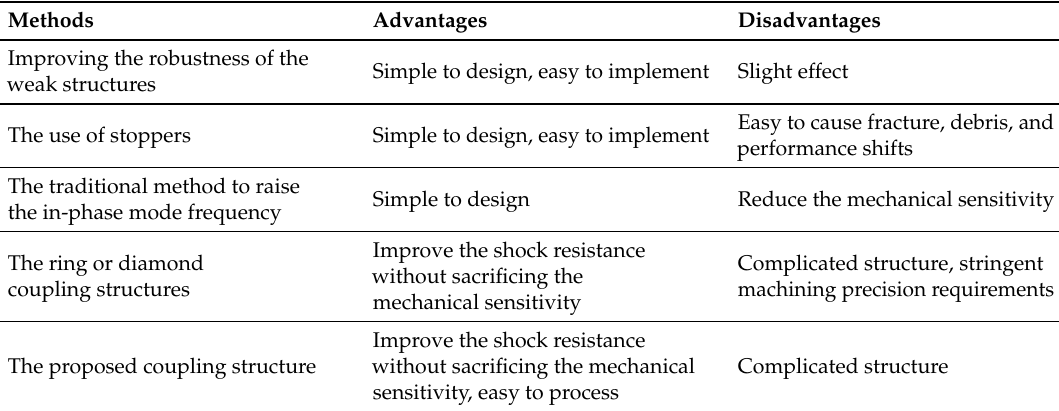
Table 8. The detailed comparisons between the proposed structure and other